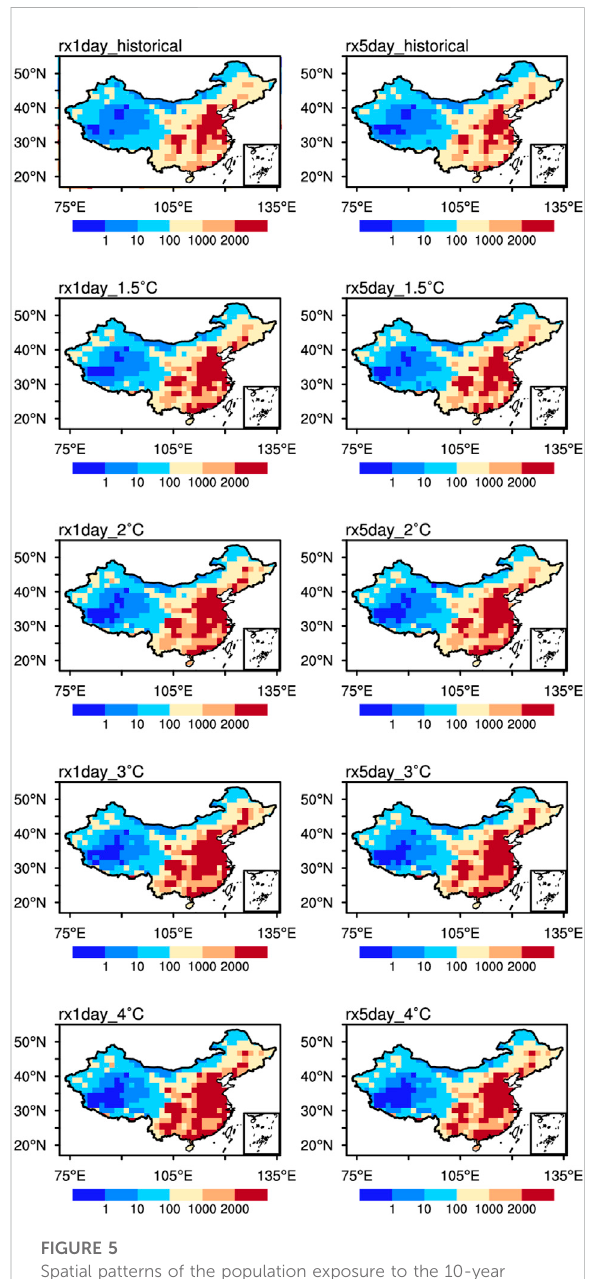
FIGURE 5 Spatial patterns of the population exposure to the 10-year events over China in the base year of 2000 (the fi rst row) and in response to the 1.5 – 4.0 ° C warming under the SSP5-8.5 scenario (the last four rows). Units: 10 4